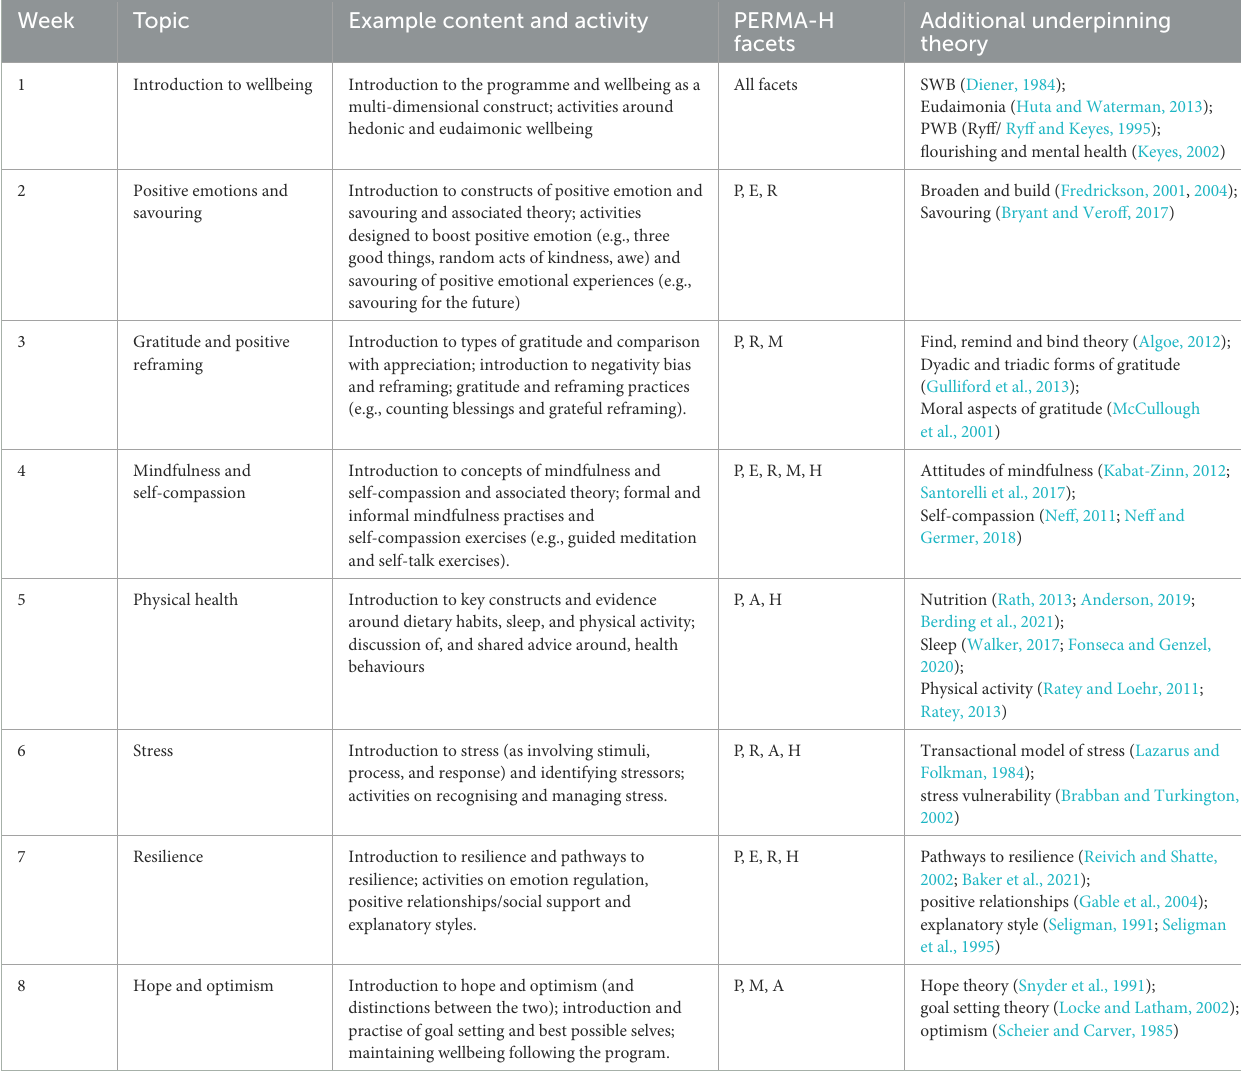
TABLE 1 Overview of the topics and content covered within the 8-week Flourish-HE wellbeing programme, with reference to the PERMA-H facets that were